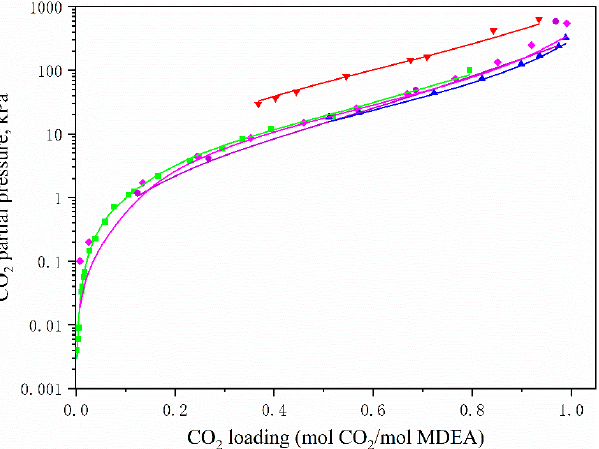
Figure 2. Comparison of experimental data and calculated data of the CO 2 –H 2 O–MDEA system under different conditions. ■ , measured by Jou et al. [43], T = 313.15 K, MDEA mass fraction = 0.35; ● , measured by Macgregor and Mather [14], T = 313.15 K, MDEA mass fraction = 0.209; ▲ ,